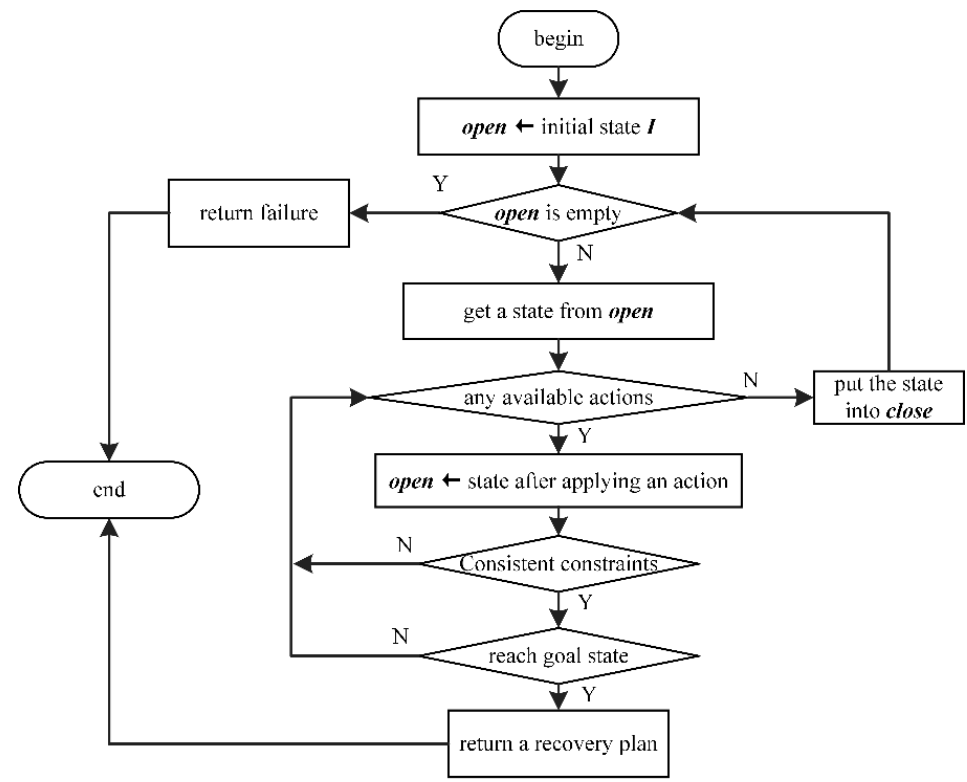
Figure 3. Schematic diagram of a search for a recovery plan.